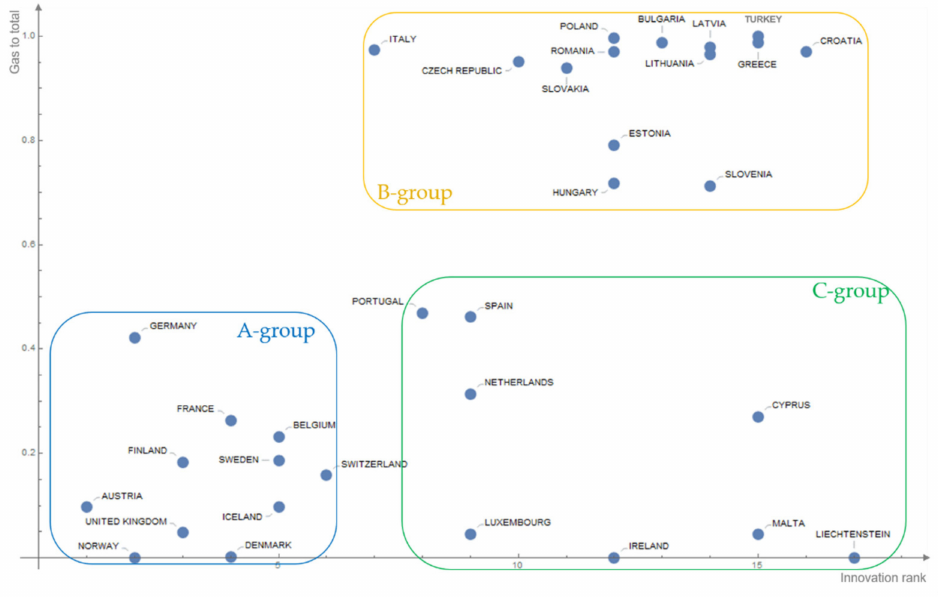
Figure 5. Cluster analysis of the EU-countries [own